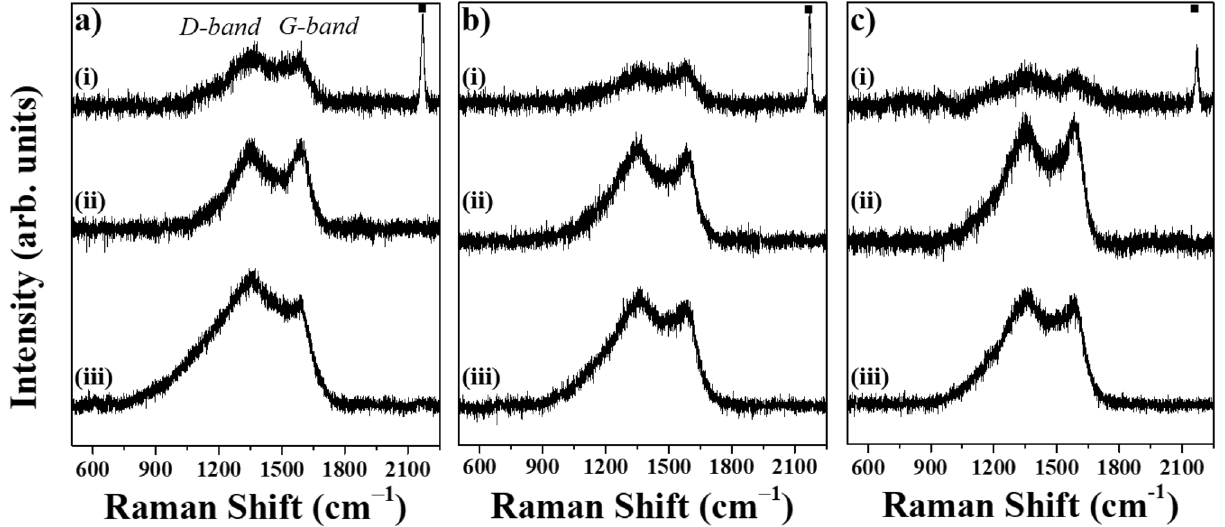
Figure 3. FT-Raman spectra of samples synthesized by PLAL of a Cu plate in (i) acetonitrile, (ii) propionitrile, and (iii) butyronitrile at different laser wavelengths of ( a ) 355, ( b ) 532, and ( c ) 1064 nm. Peaks at 1350 and 1590 cm −1 correspond to the D- and G-bands of the sp 2 hybridized carbon, respectively. They were attributed to GC shells on the surface of spherical Cu NPs. The characteristic CuCN peak at 2170 cm −1 is indicated by ( ▪